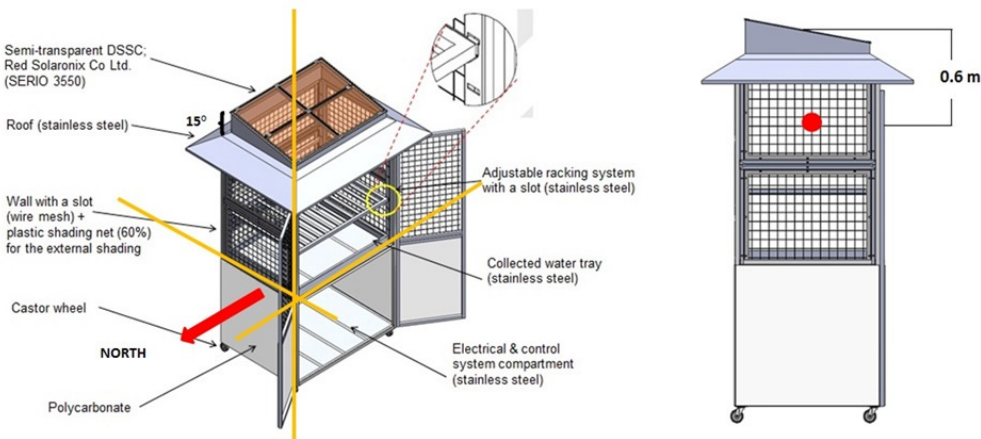
Figure 1. The detailed drawings of construction and compositions in Portable Dye-Sensitized Solar Cell Mini Greenhouse (PDMG) and the location temperature and relative humidity sensors inside the PDMG.